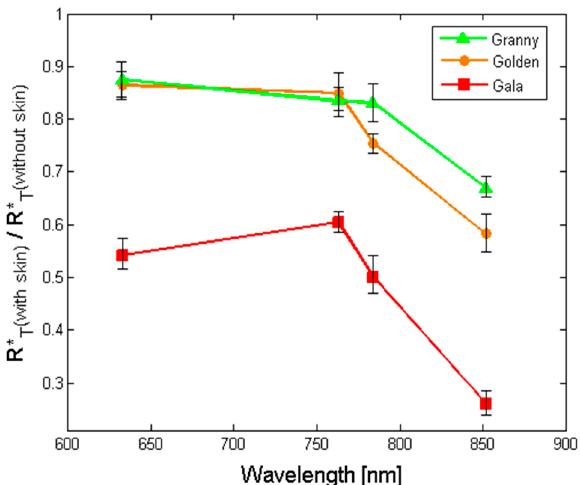
Figure 8. Plots of the total reflection ratio α ∗ as a function of the wavelength, for three apple cultivars with and without skin.